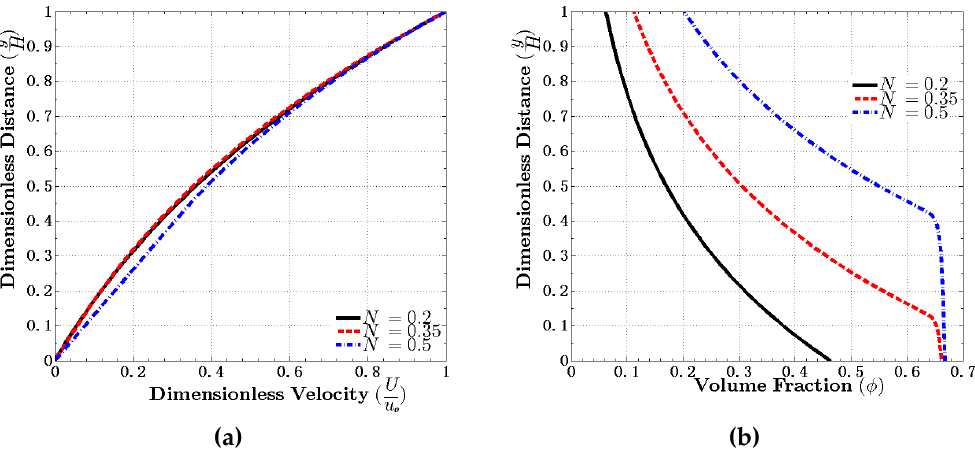
Figure 8. The effect of 𝑁 on the velocity profile ( a ) and the volume fraction profile ( b ), when 𝑅 = 1 , 𝑚 = 1 , (2𝑀 (cid:2869) + 𝑀 (cid:2870) ) = 1 , 𝐵 (cid:3043) = −1 , 𝐵 (cid:3045) = −10 , 𝜙 (cid:3030) = 0.68 , 𝑆 = 100 , 𝐹𝑟 = 0.5 .